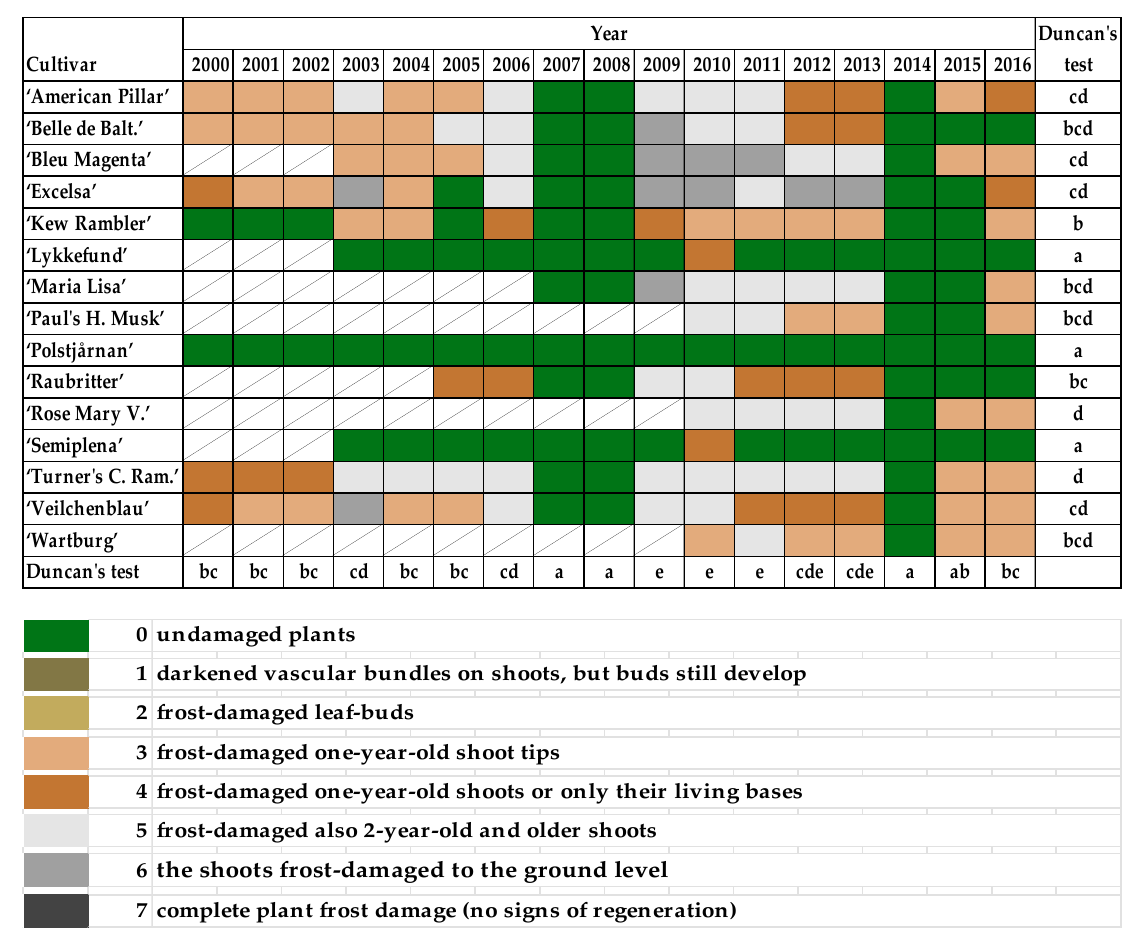
Figure 5. Frost damage of rambler roses according to the following scale: 0—undamaged plants; 1—darkened vascular bundles on shoots, but buds still develop; 2—frost-damaged leaf-buds; 3—frost-damaged one-year-old shoot tips; 4—frost-damaged one-year-old shoots or only their living bases; 5—frost-damaged also 2-year-old and older shoots; 6—shoots frost-damaged to the ground level; 7—complete plant frost damage (no signs of regeneration). Different letters indicate significant differences between cultivars and years. The Duncan’s test ( α = 0.05) was used. Table 2. Correlations between average monthly air temperature (2005/2006, 2009/2010, and 2015/2016) and frost damage of rambler